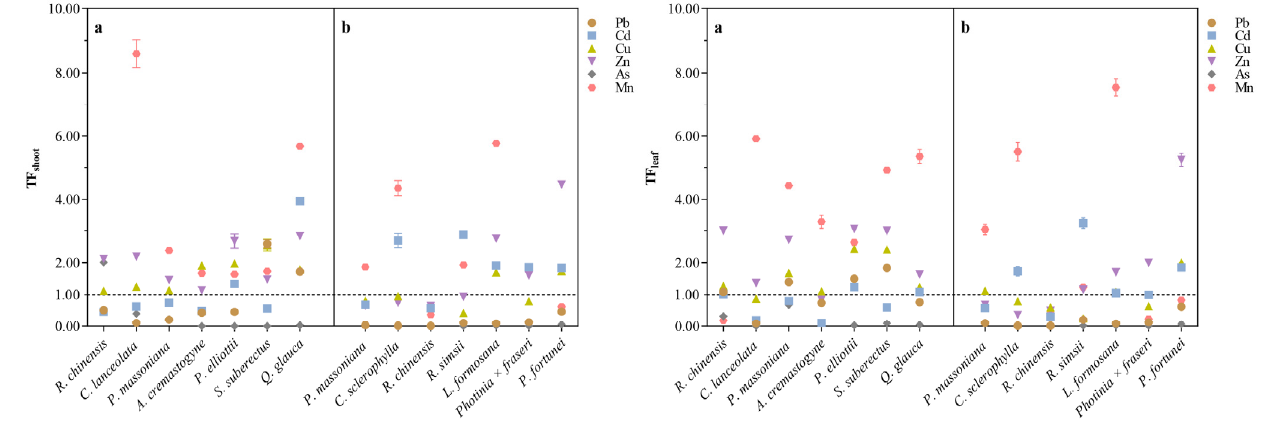
Figure 7. The TFs of heavy metals in the shoots and leaves of each woody plant in the Jiulong iron tailing area ( a ) and Yangtiangang lead-zinc tailing area ( b ).